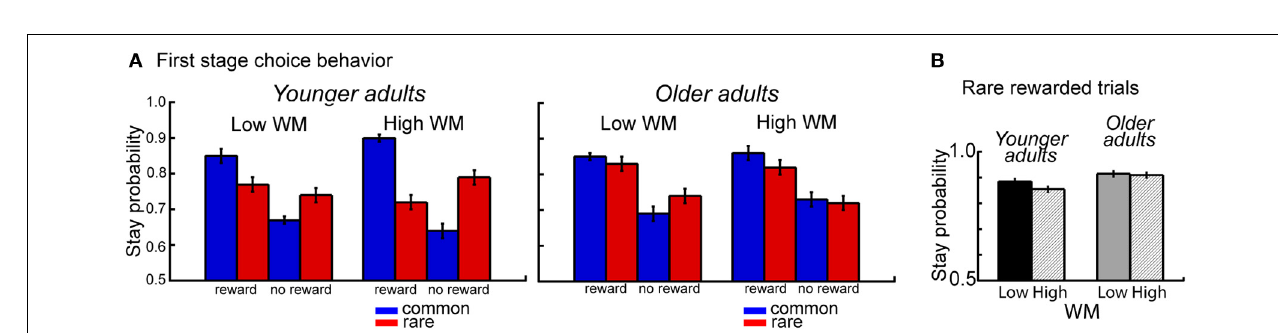
FIGURE 3 | (A) Probability of repeating the same first stage choice as a function of the transition on the previous trials (common, rare transition) and the outcome received on the previous trial (reward, no reward). Stay probabilities are displayed separately for younger adults (left panel) and older